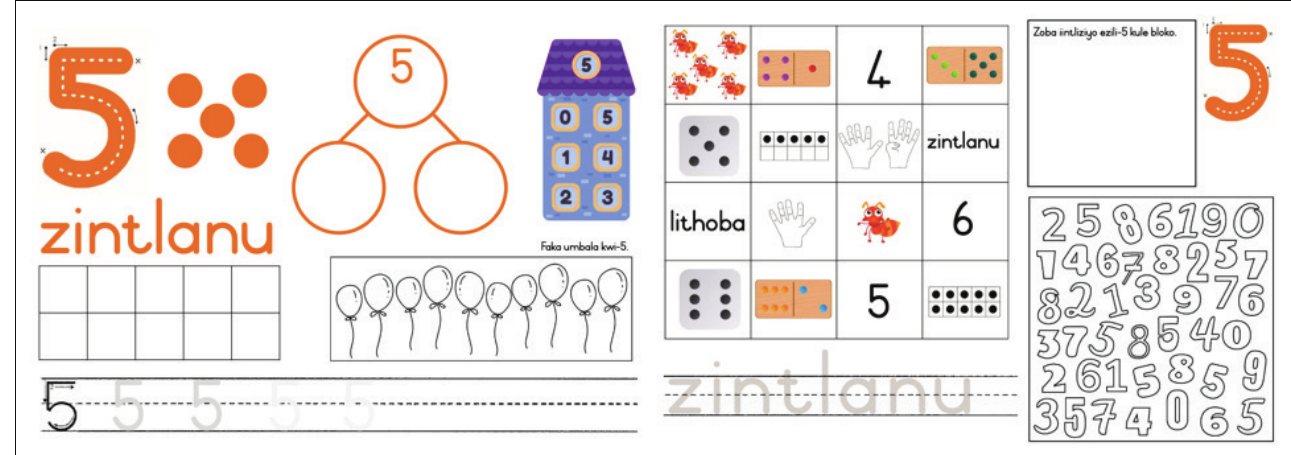
FIGURE 4: Samples of early number concept activities that have been